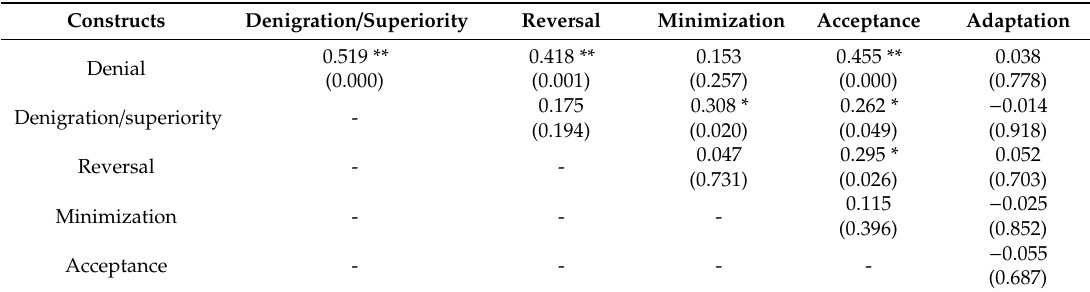
Table 5. Pearson Correlation.